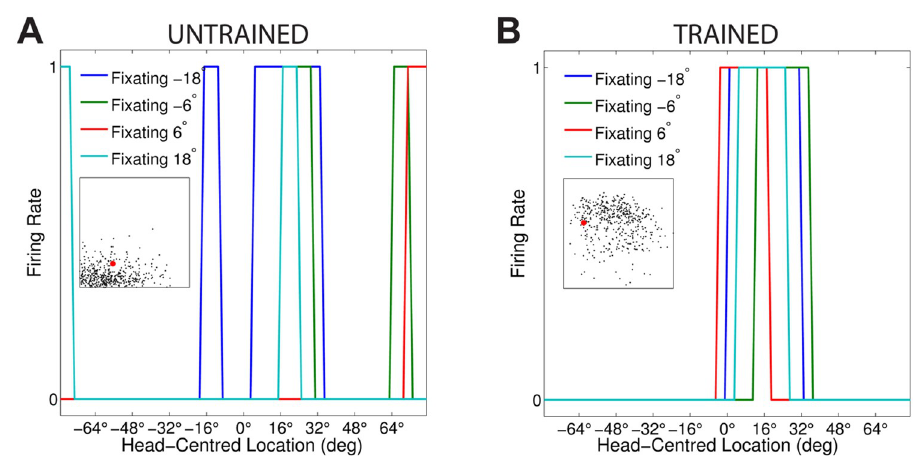
Fig 24. Simulation results of a model incorporating a mixed population of peaked and sigmoidal modulated input neurons, with sigmoidal modulation rate p set to 0.5, trained with the modified learning rule 20: Delayed postsynaptic trace learning rule. The figure shows the firing rate responses of output neuron #281 before training (A) and after training (B) during testing for four different eye-positions: − 18˚, − 6˚, 6˚ and 18˚. Conventions as for Fig 12. Plot (B) shows that the same output neuron learned to respond to a specific head-centred location regardless of the eye-position after training.